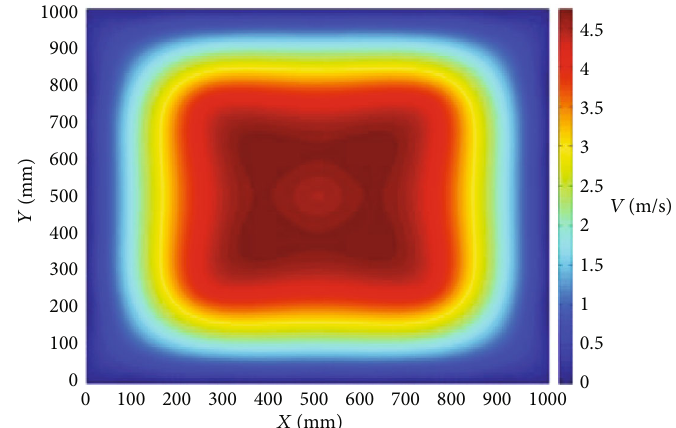
Figure 7: Cloud picture of fl ow velocity.